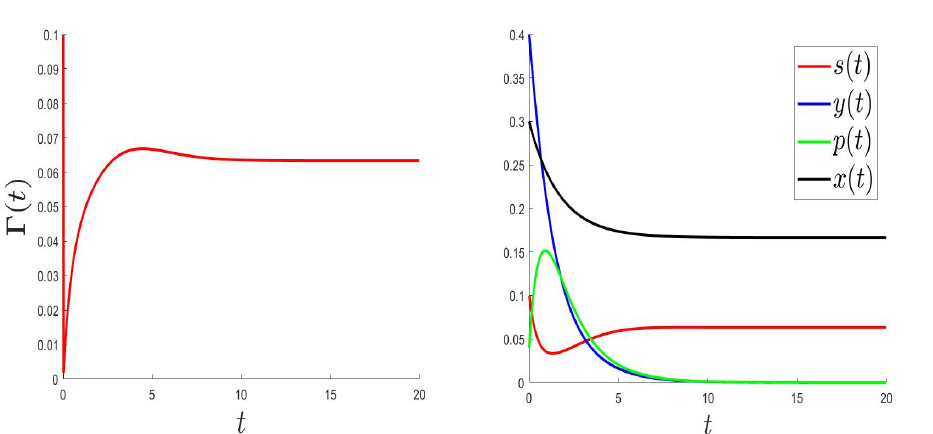
Figure 2. Behaviours for (cid:101) = 1.2, η 1 = 0.2 and η 2 = 0.5, then R 0 = 0.53 < 1.